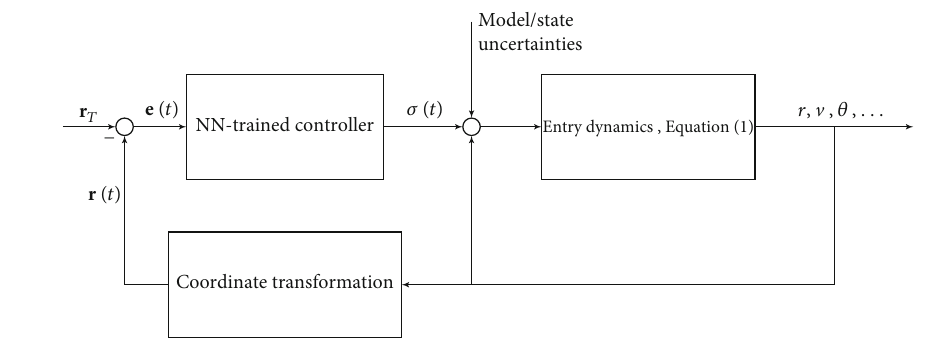
Figure 3: Applied neural network in control system. Table 4: Linear integration using 10-layer NN in the Earth model.